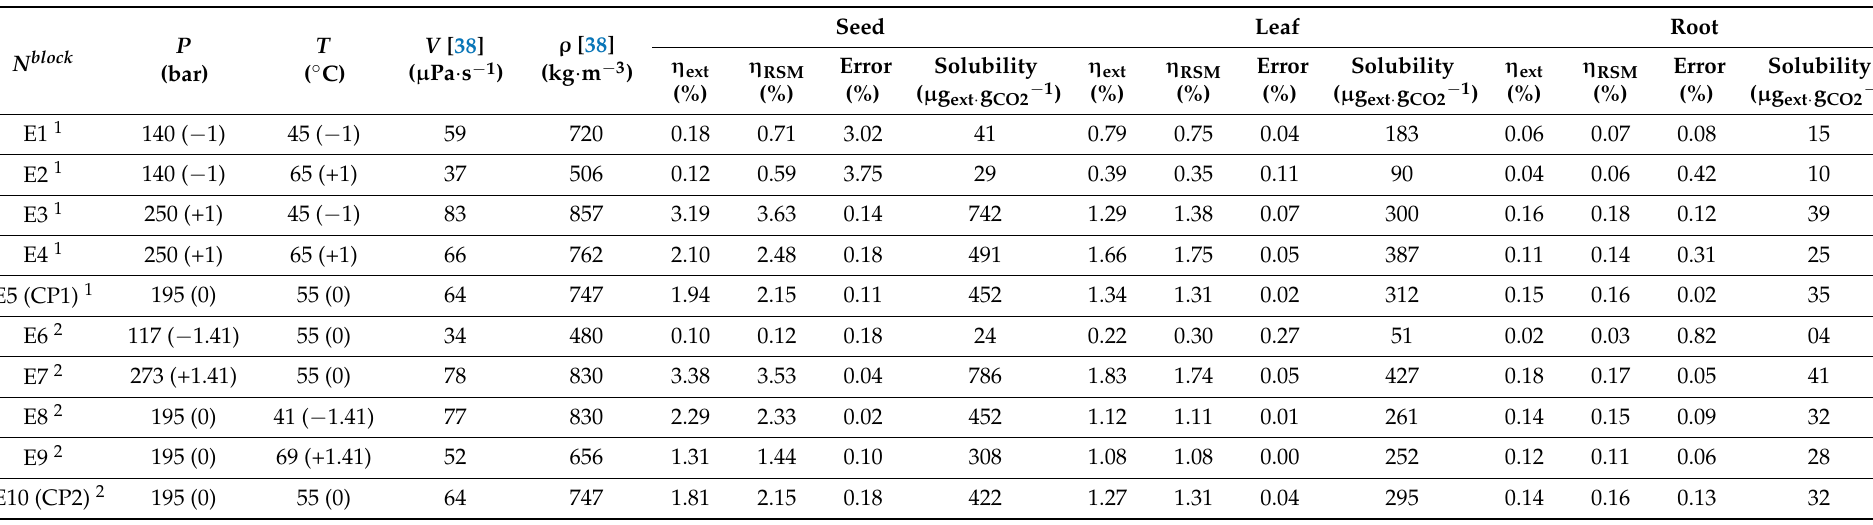
Table 1. DOE procedure (2 2 + 2 central points, twoblocks) for Mo seed, leaf, and root SFE-CO 2 extracts, and their thermodynamic